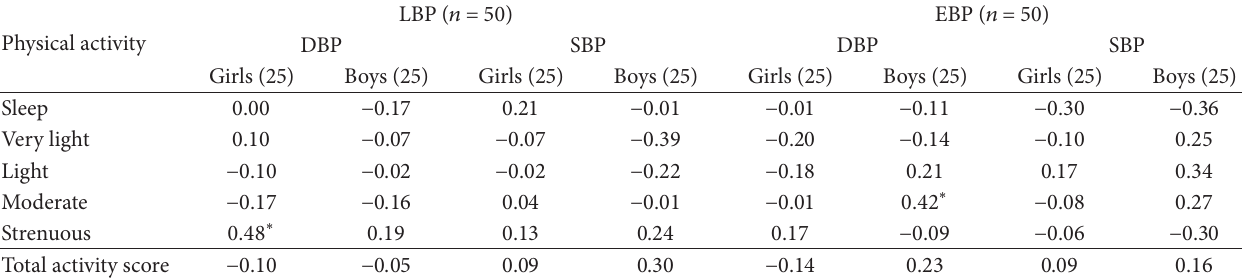
Table 3: Correlation coefficient of blood pressure of LBP and EBP group in boys and girls by physical activity and energy